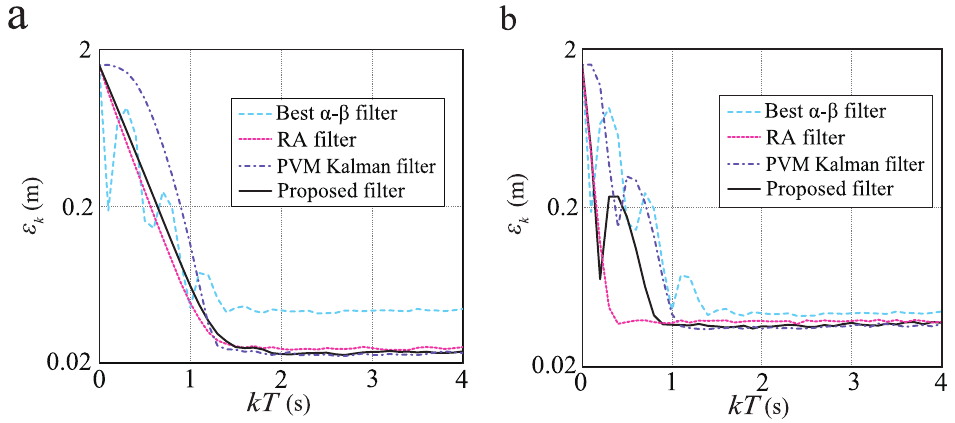
Figure 4. Simulation results for ( a ) R xv = 9 and ( b ) R xv = 1; PVM: position-velocity-measured. Table 3. Steady state RMS prediction error of the proposed filter for various a c ( R xv = 9). a c (m/s 2